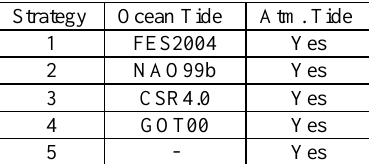
Table 1. Processing Strategies